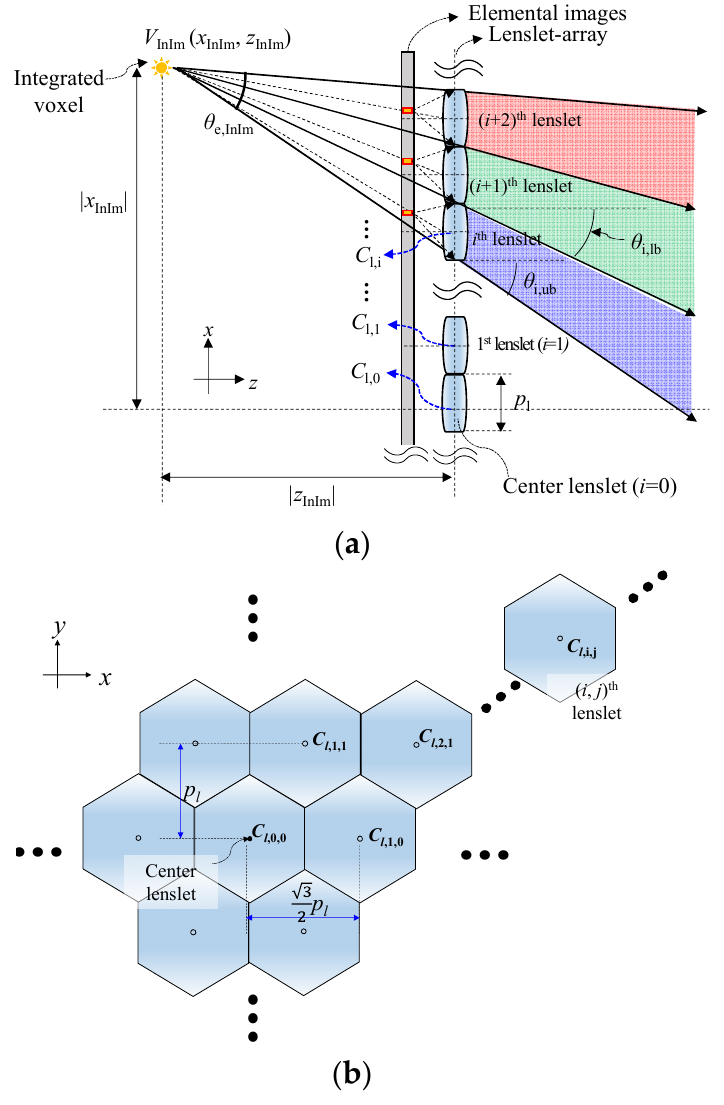
Figure 5. The schematic diagram for the emission angle construction of voxels in the InIm system: ( a ) the emission angle formation of integrate voxel in the InIm with the symmetrically arranged lenslet-array, and ( b ) the diagram for the arrangements and coordinates of lenslet center in the hexagonal lenslet-array.